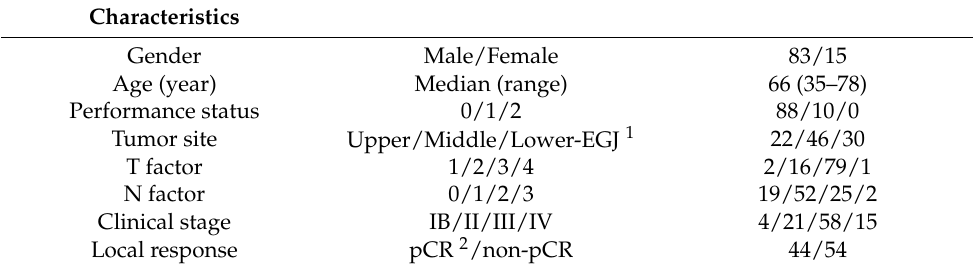
Table 1. Characteristics of